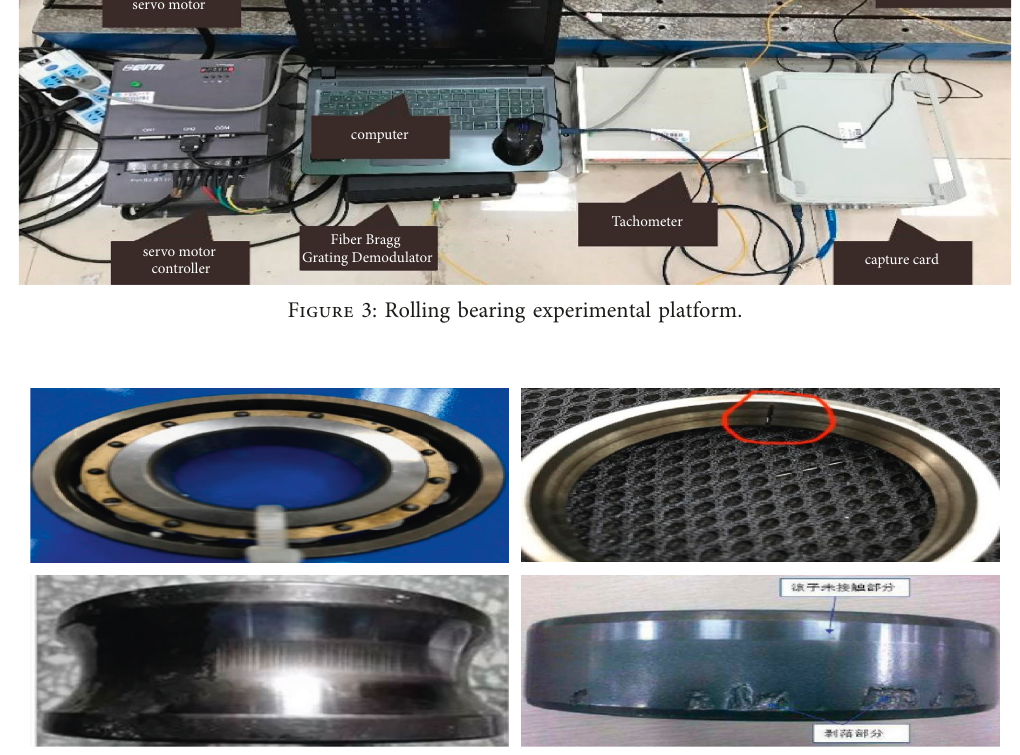
Figure 4: Comparison between intact bearing and three types of example defective bearing comparison diagram.